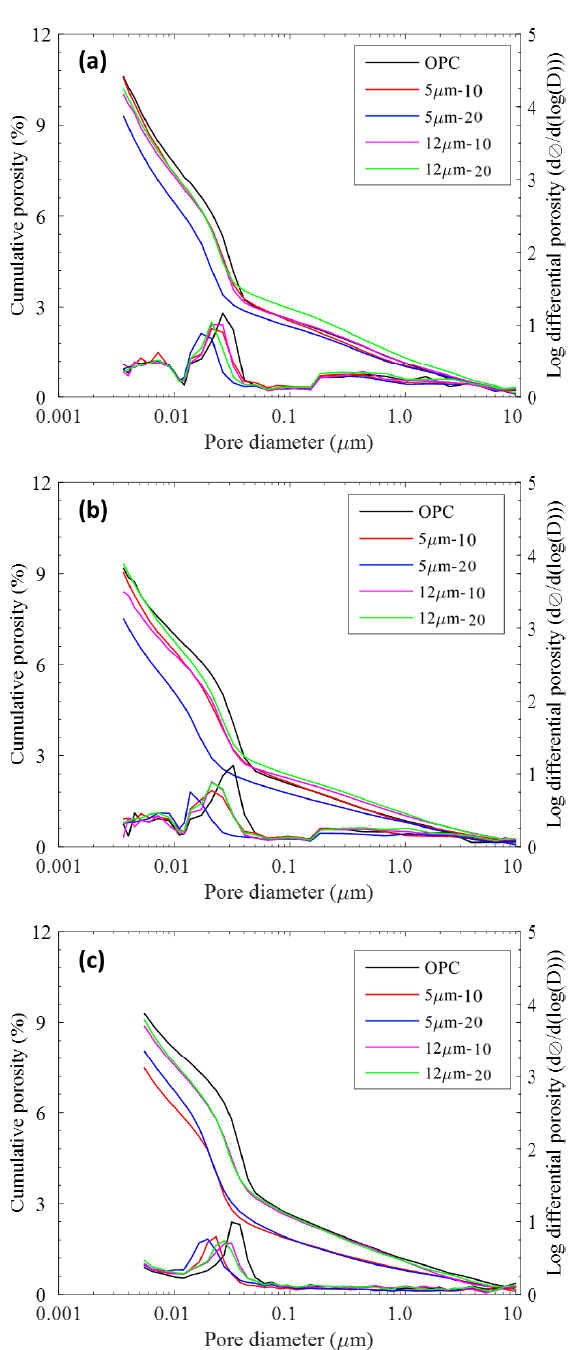
Figure 5. Cumulative porosity and log-differential porosity plots at ( a ) 7 days, ( b ) 14 days, and ( c ) 28 days. Table 2. Bulk and skeletal densities obtained through MIP.